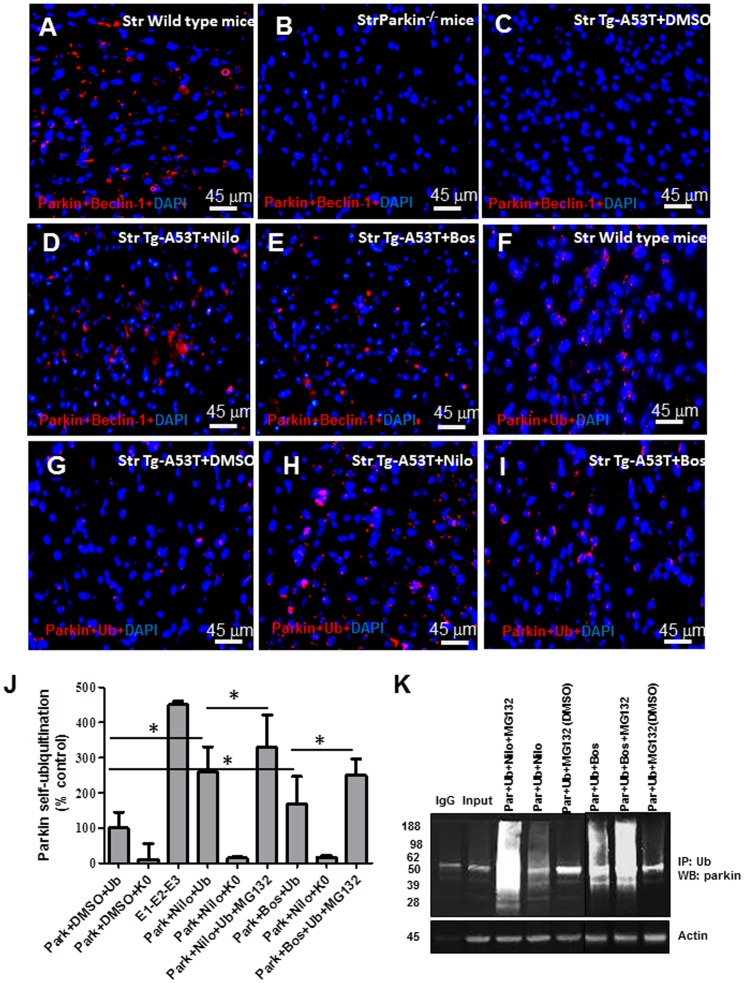
TKI increases parkin ubiquitination and interaction with Beclin-1.
In Situ PLA in 20 µm thick mouse brain sections shows A) parkin-Beclin-1 interaction in the striatum of C57BL/6 control, B) parkin−/− mice, C) transgenic A53T mice treated with daily I.P injection for 3 weeks of DMSO D) 10 mg/kg nilotinib and E) 5 mg/kg bosutinib (n = 5). In situ PLA in 20 µm thick mouse brain sections showing parkin ubiquitination via F) parkin-ubiquitin interaction in the striatum of C57BL/6 control, G) transgenic A53T mice treated with daily I.P injection for 3 weeks of DMSO H) 10 mg/kg nilotinib and I) 5 mg/kg bosutinib (n = 5). J) Histograms represent parkin ubiquitination in B35 rat neuroblastoma cells treated with either 10 µM nilotinib or 1 µM bosutinib and 20 µM proteasome inhibitor MG132. Parkin ubiquitination was observed with WT ubiquitin not the K0 control (n = 6), compared to recombinant E1-E2-E3 control. Asterisk indicates significantly different, means±SEM, ANOVA, Newman Keuls, n = 6) and K). immnunoprecipitation of cell extracts with anti-ubiquitin antibodies and WB with parkin showing ubiquitinated proteins (n = 5).